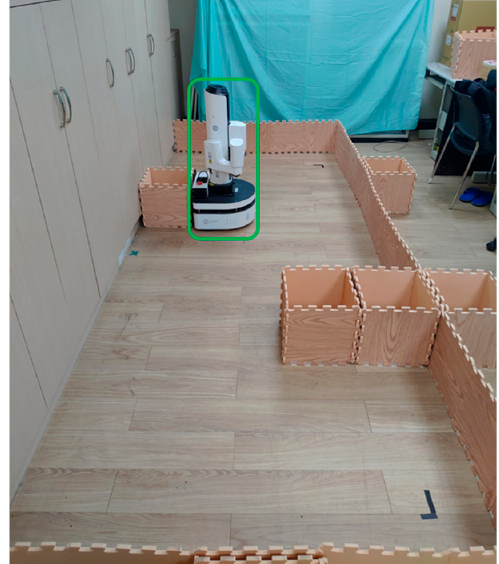
Figure 12. The unknown fixed obstacle.